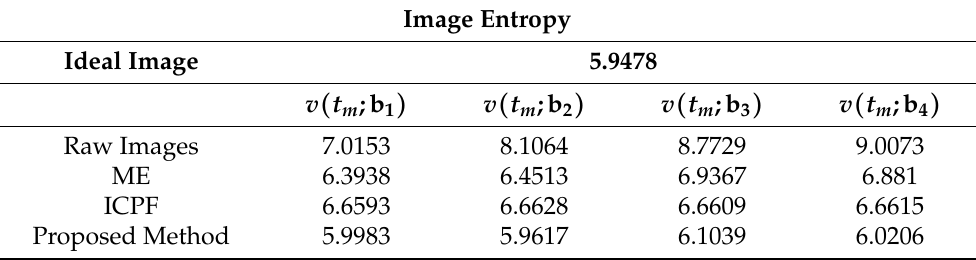
Figure 15. Comparison of estimated velocity and real velocity using Yak-42 measured data at different motion conditions. Table 8. The entropy of images acquired by different algorithms using Yak-42 measured data.